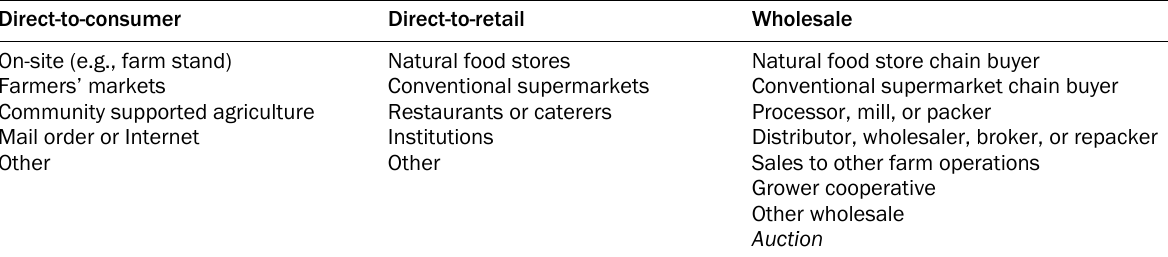
Table 2. Marketing Channels Included in the OPS Questionnaire, with the Addition of Auction